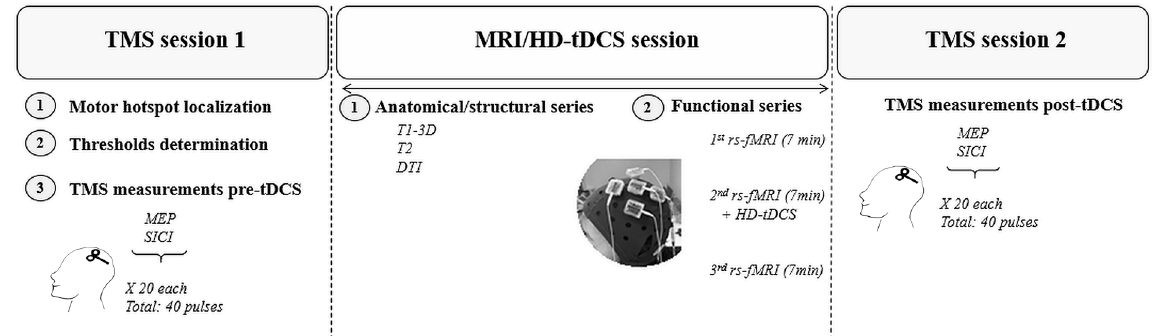
Figure 6. Study design. Each participant participated in 3 sessions within one day as follows: a first TMS session, then an MRI/HD-tDCS session, and finally a second TMS session. HD-tDCS: high-definition transcranial direct current stimulation, MEP: Motor Evoked Potential, RMT: Resting Motor Threshold, rs-fMRI: resting-state functional magnetic resonance imaging